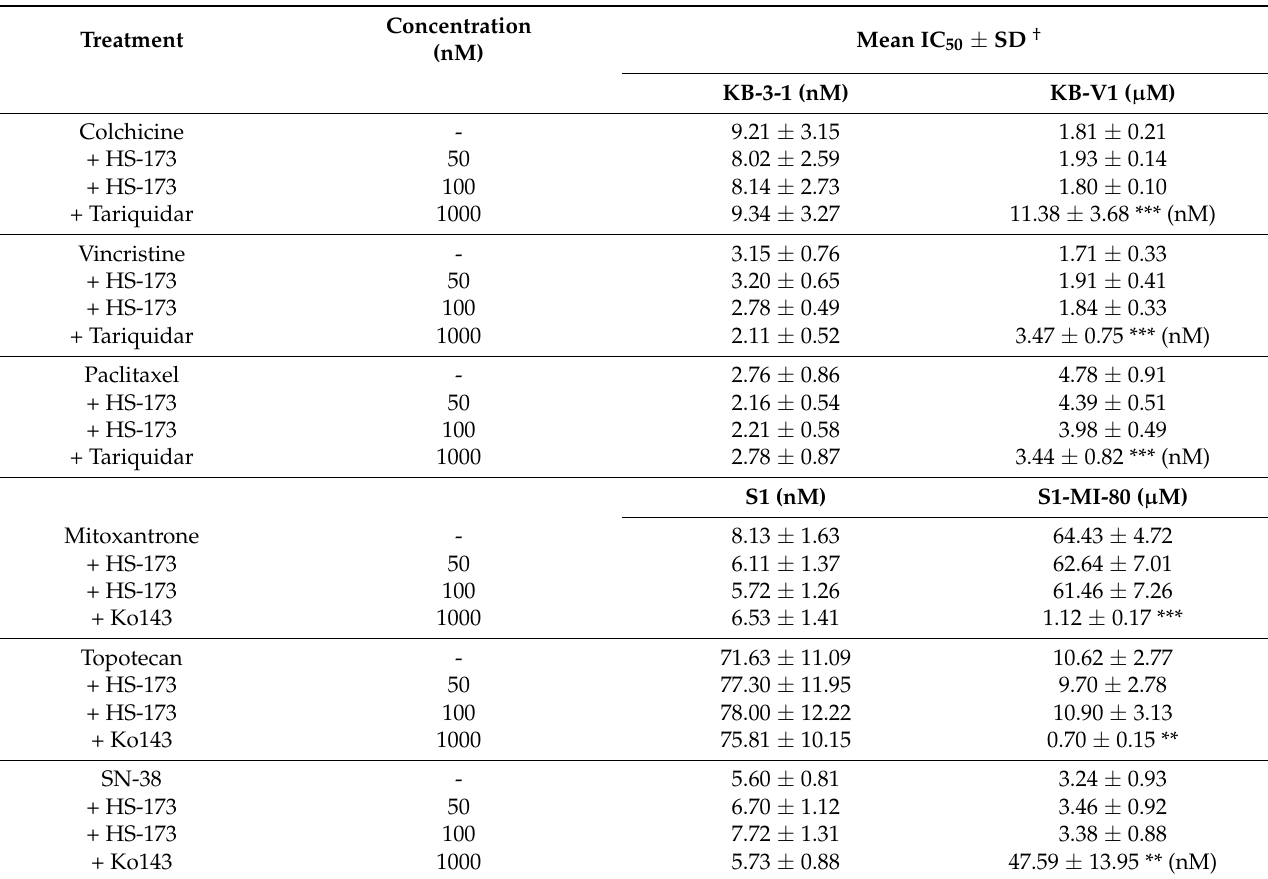
Table 3. Effect of HS-173 on ABCB1- and ABCG2-mediated multidrug resistance in ABCB1- and ABCG2-overexpressing cancer